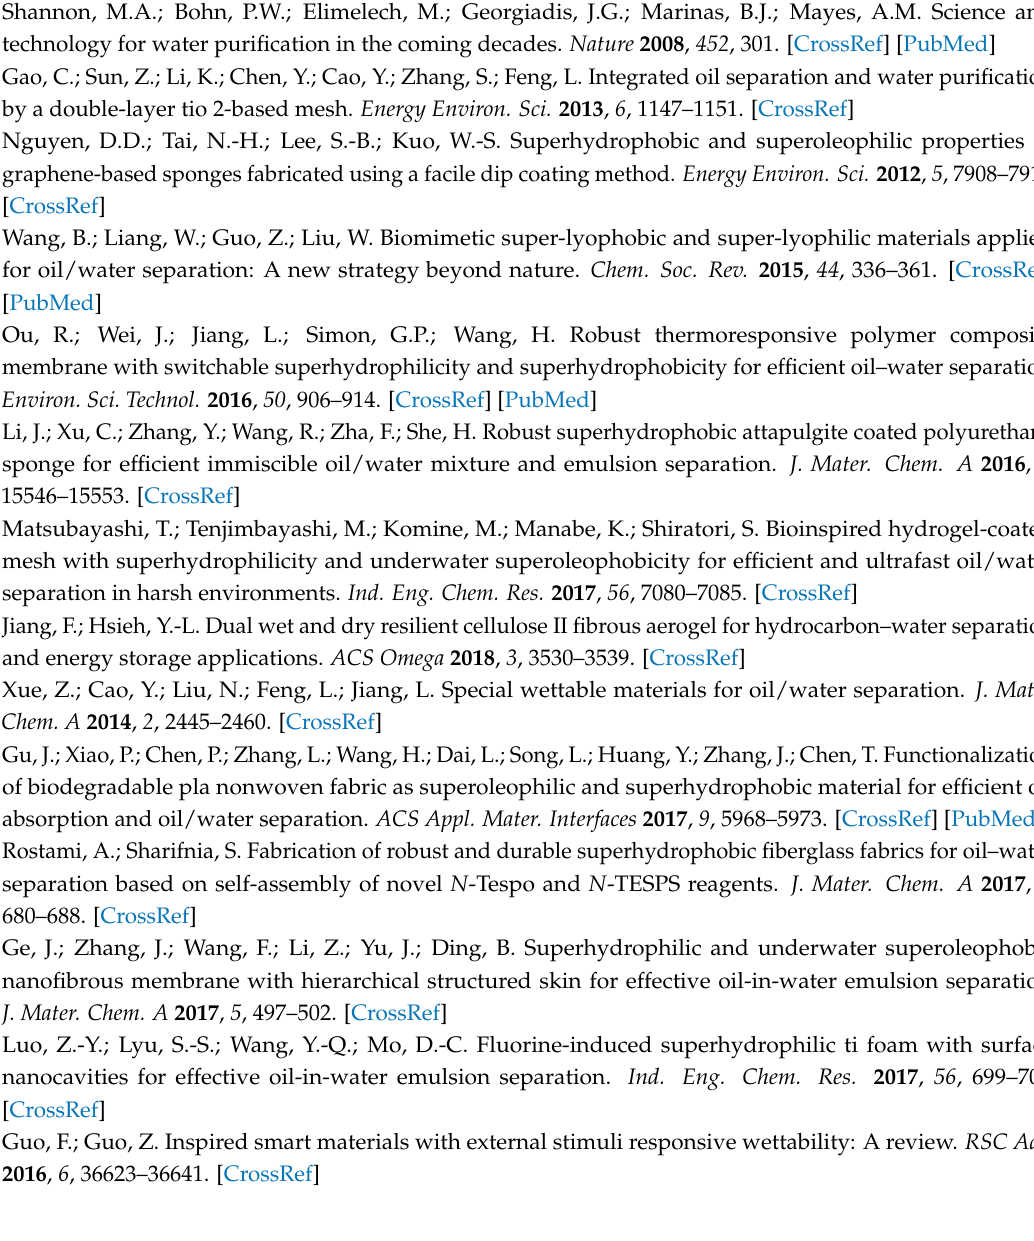
paper. The oil/water mixture is composed of oil dyed by Sudan (III)/water. The left and right inset shows the water droplet (top) and oil droplet (bottom) on corresponding cellulose. Table S1: The element content of cellulose and cellulose- g -PNIPAAm measured by Elemental Analysis. Table S2: The element content of cellulose and cellulose- g -PNIPAAm measured by X-ray Photoelectron